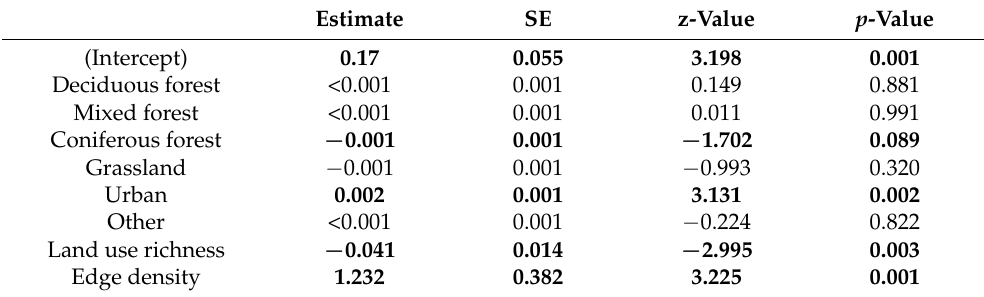
Table 7. GLM model results accounting for species richness of five Columbidae species concerning different land use types, land use richness, and edge density in 2016. The included species are feral pigeon ( Columba livia forma domestica ), stock dove ( Columba oenas ), wood pigeon ( Columba palumbus ), Eurasian collared dove ( Streptopelia decaocto ), and European turtle dove ( Streptopelia turtur ). Abbreviations: SE—standard error. Significant variables are highlighted in